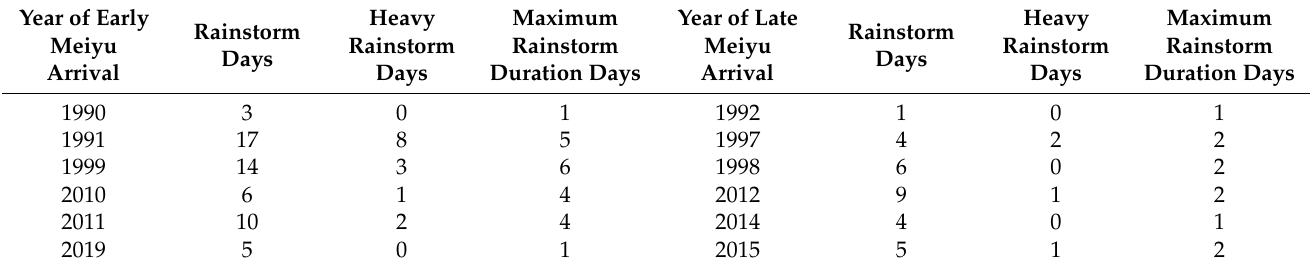
Table 2. Comparison of rainstorms in the Meiyu period in Jiangsu